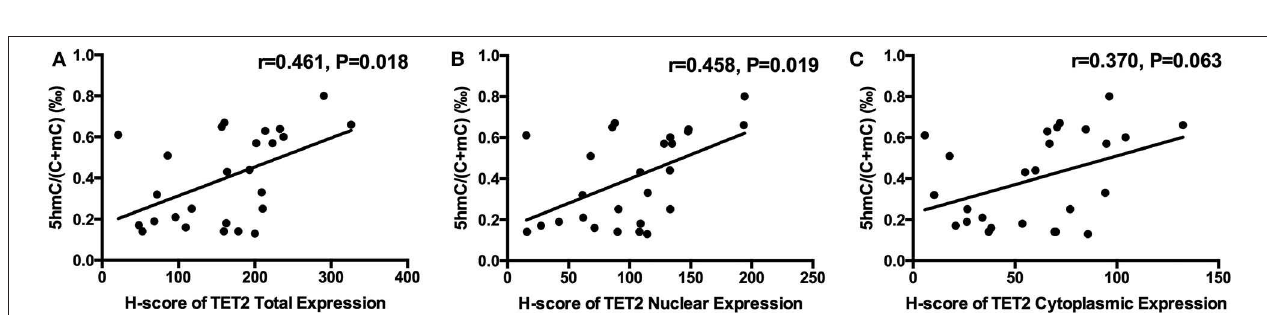
FIGURE 3 | TET2 expression and localization in the normal pituitary gland and NFPAs. (A) TET2 localized in the nucleus of the normal pituitary gland. (B) TET2 also localized in the nucleus of NFPAs. (C) TET2 localized in the cytoplasm of the normal pituitary gland. (D) TET2 also localized in the cytoplasm of NFPAs.